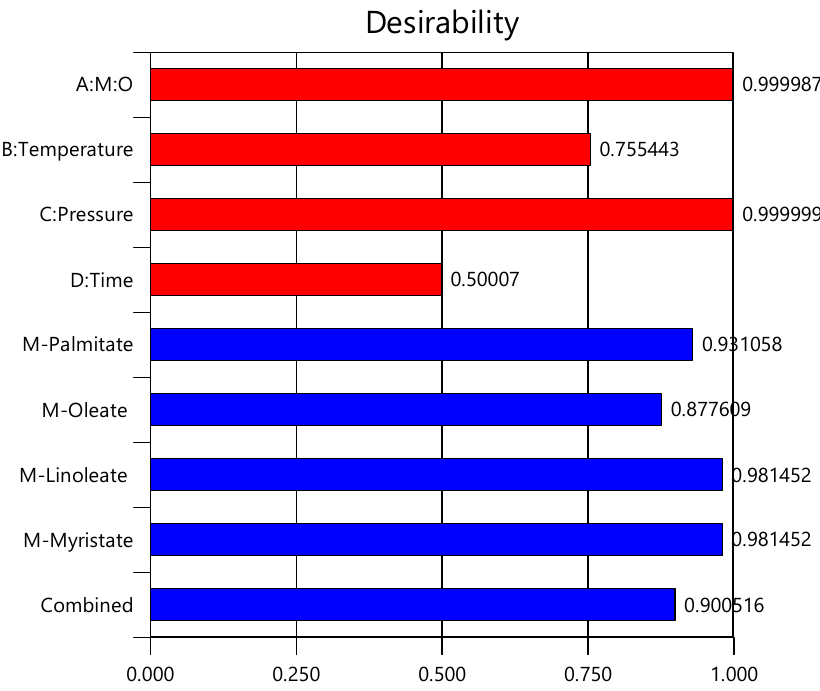
Figure 3. Response surface for the effect of reaction pressure and time on the yield of methyl-oleate.